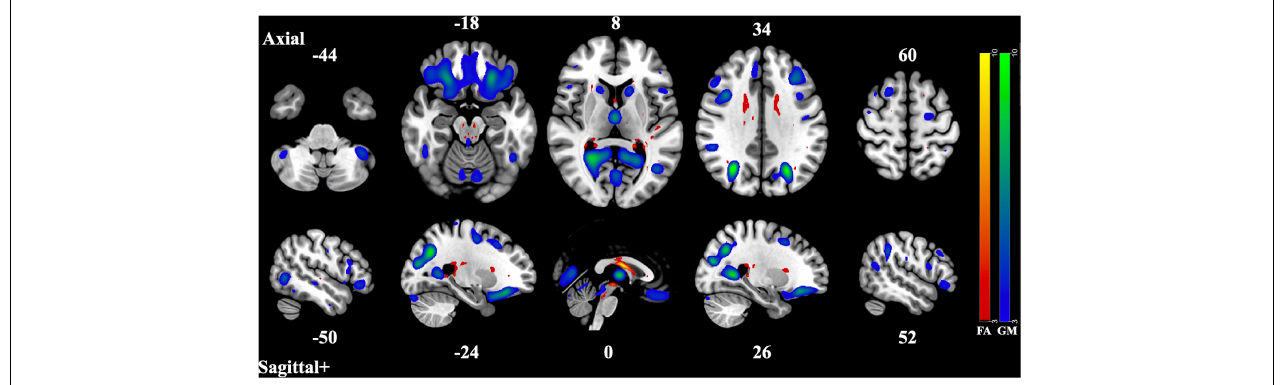
FIGURE 1 | Component Pair 1, Intermodal spatial map highlighting the correlated FA and GM changes that differ significantly (Bonferroni-corrected for multiple comparisons), HC > SZ, z > |3|. pICA correlation between structural networks, r = 0.61 ( t = 9.56, p = 2.87 × 10 – 17 ). FA cases vs. controls differences, t = 3.21, p = 0.0016, GM cases vs. controls, t = 3.63, p = 0.00039. Red-yellow represents the FA group differences, blue-green represents the GM group differences. See Supplementary Figures 1–2 for full axial and sagittal